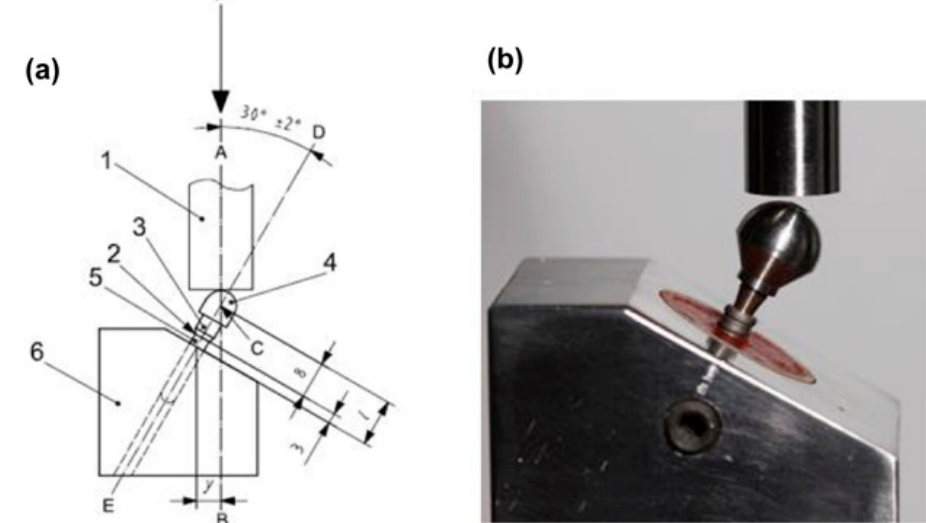
Figure 3. ( a ) Internation Organization for Standardization (ISO) 14801:2007 standard (1. force device; 2. bone level; 3. component; 4. hemispheric loading component; 5. implant body; 6. test body support); ( b ) sample placed on the device to perform the test.